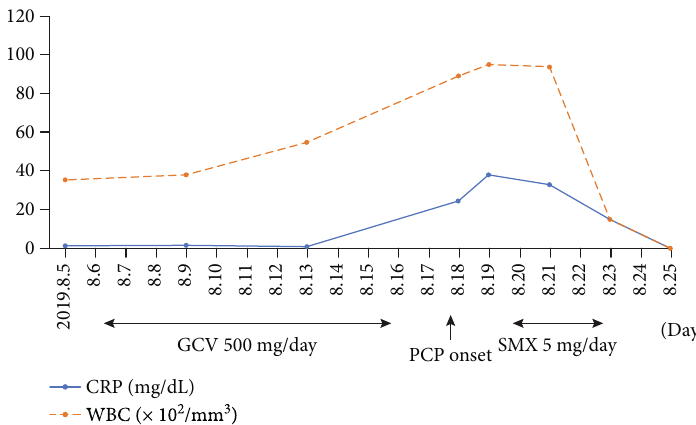
Figure 5: CRP and WBC levels and the administered medications during hospitalization are shown. CRP: C-reactive protein; WBC: leukocytes; GCV: ganciclovir; PCP: pneumocystis pneumonia; SMX: